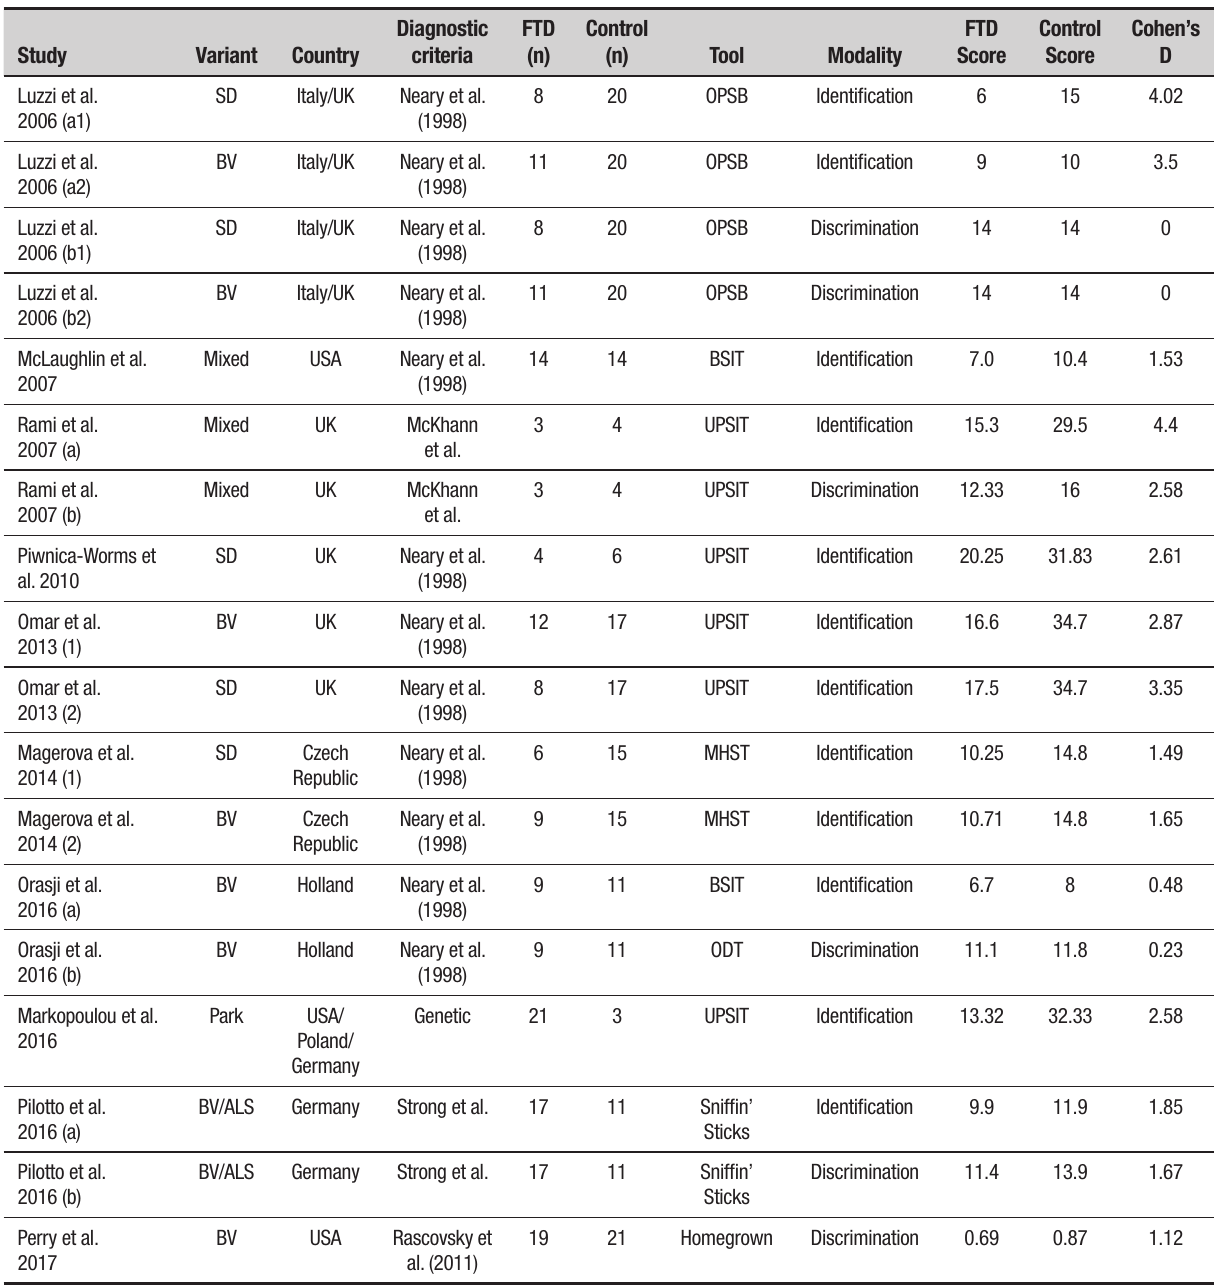
Table 1. Characteristics of